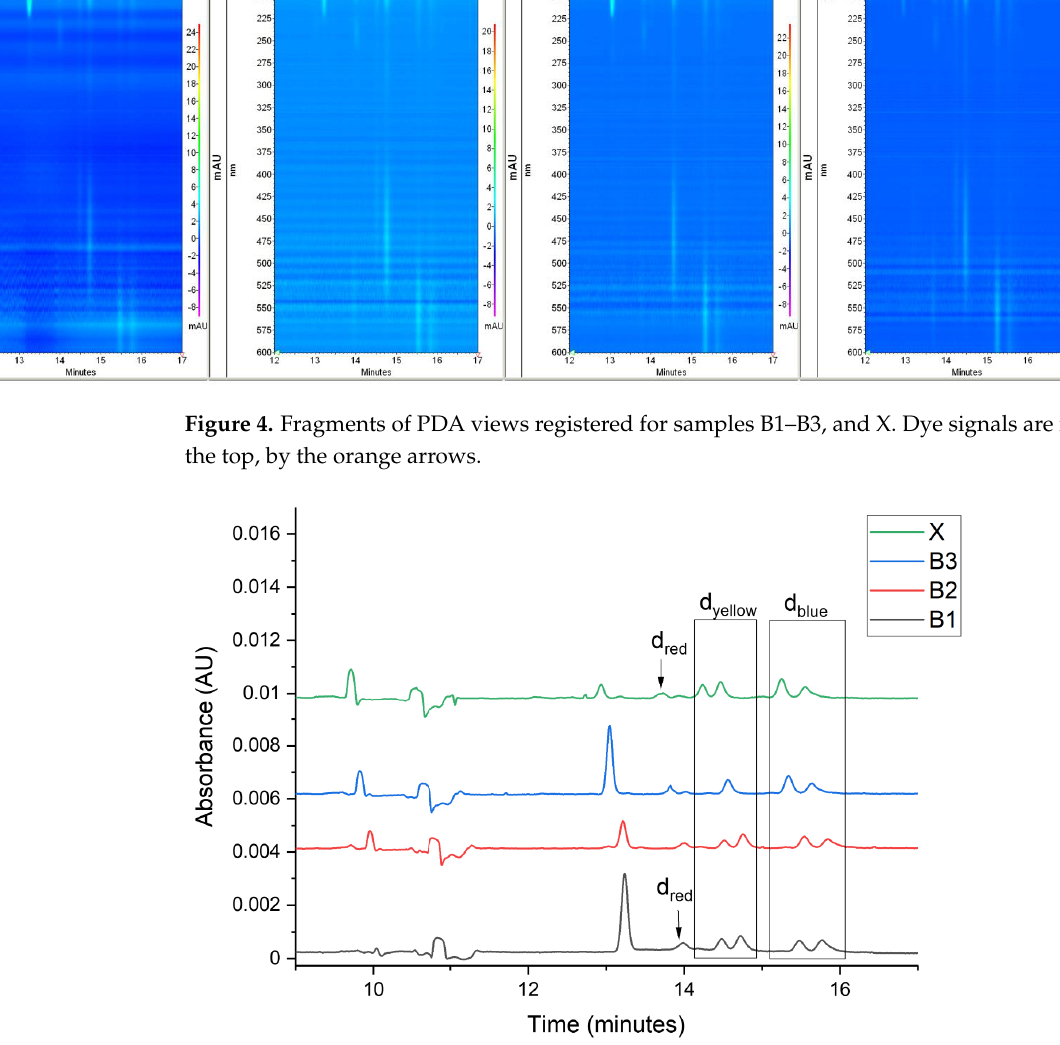
Figure 5. Electropherograms registered for samples B1 – B3, and X at 220 nm, d red — red dyes, d yellow — yellow dyes, d blue — blue dyes. The total number of signals, as so the number of dye signals, make it possible to ex- clude the common origin of samples B3 and X. The number of dye signals and the absorp- tion bands in the Vis spectrum showed the differences in the composition of extracts from samples B1 and X. The same number of signals (total and dye), and the absorption bands in the Vis spectrum (dye color) indicate the similarity of samples B2 and X. The calculated U values are lower than 0.11 for all peaks and show very good similarity. The results led to the conclusion that samples B2 and X were, with very likelihood, preserved from the same material.